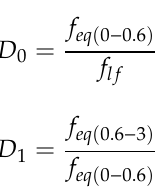
( b ) ( c ) Figure 6. Representative parameters for tested fiber-reinforced concrete (FRC) mixtures: ( a ) work capacity indices, ( b ) first crack and equivalent strengths, ( c ) ductility indices.